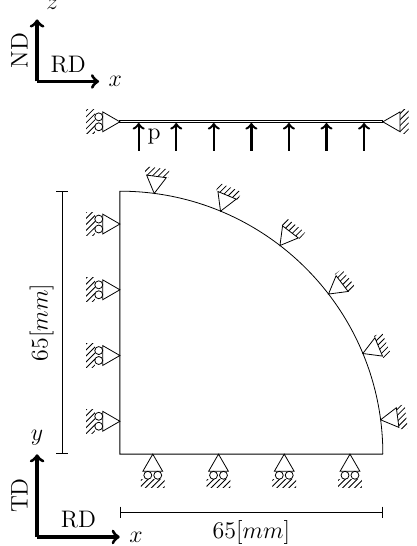
Figure 5. Bulge test boundary conditions (side and top